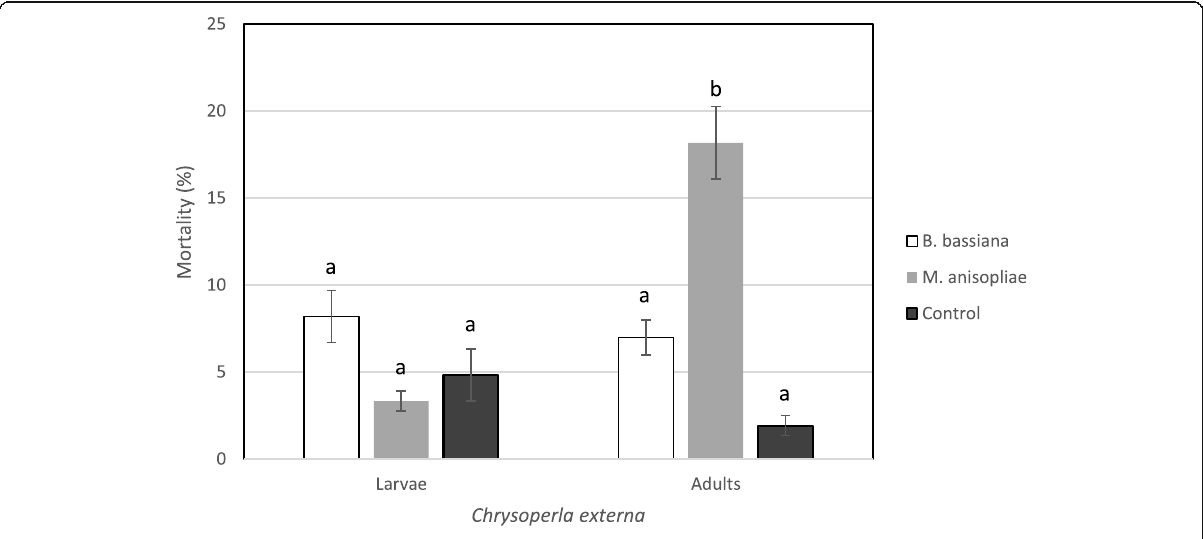
Fig. 3 Mortality percentage of larvae and adults of Cycloneda externa with entomopathogenic fungi